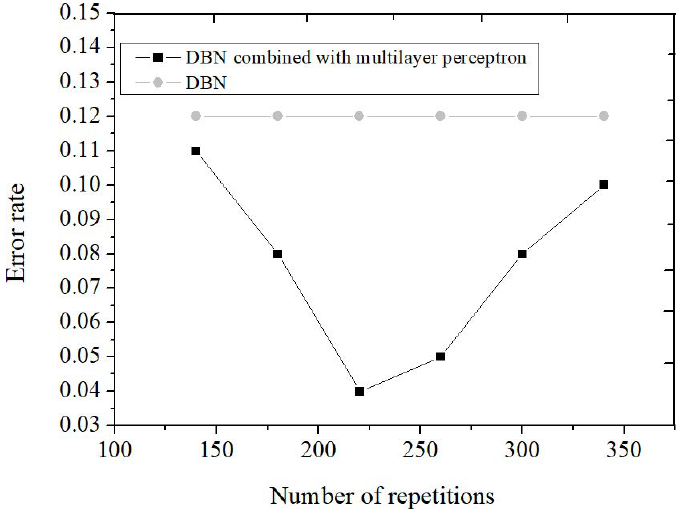
Fig. 5 Relationship between model error rate and repetition number. DBN: deep belief